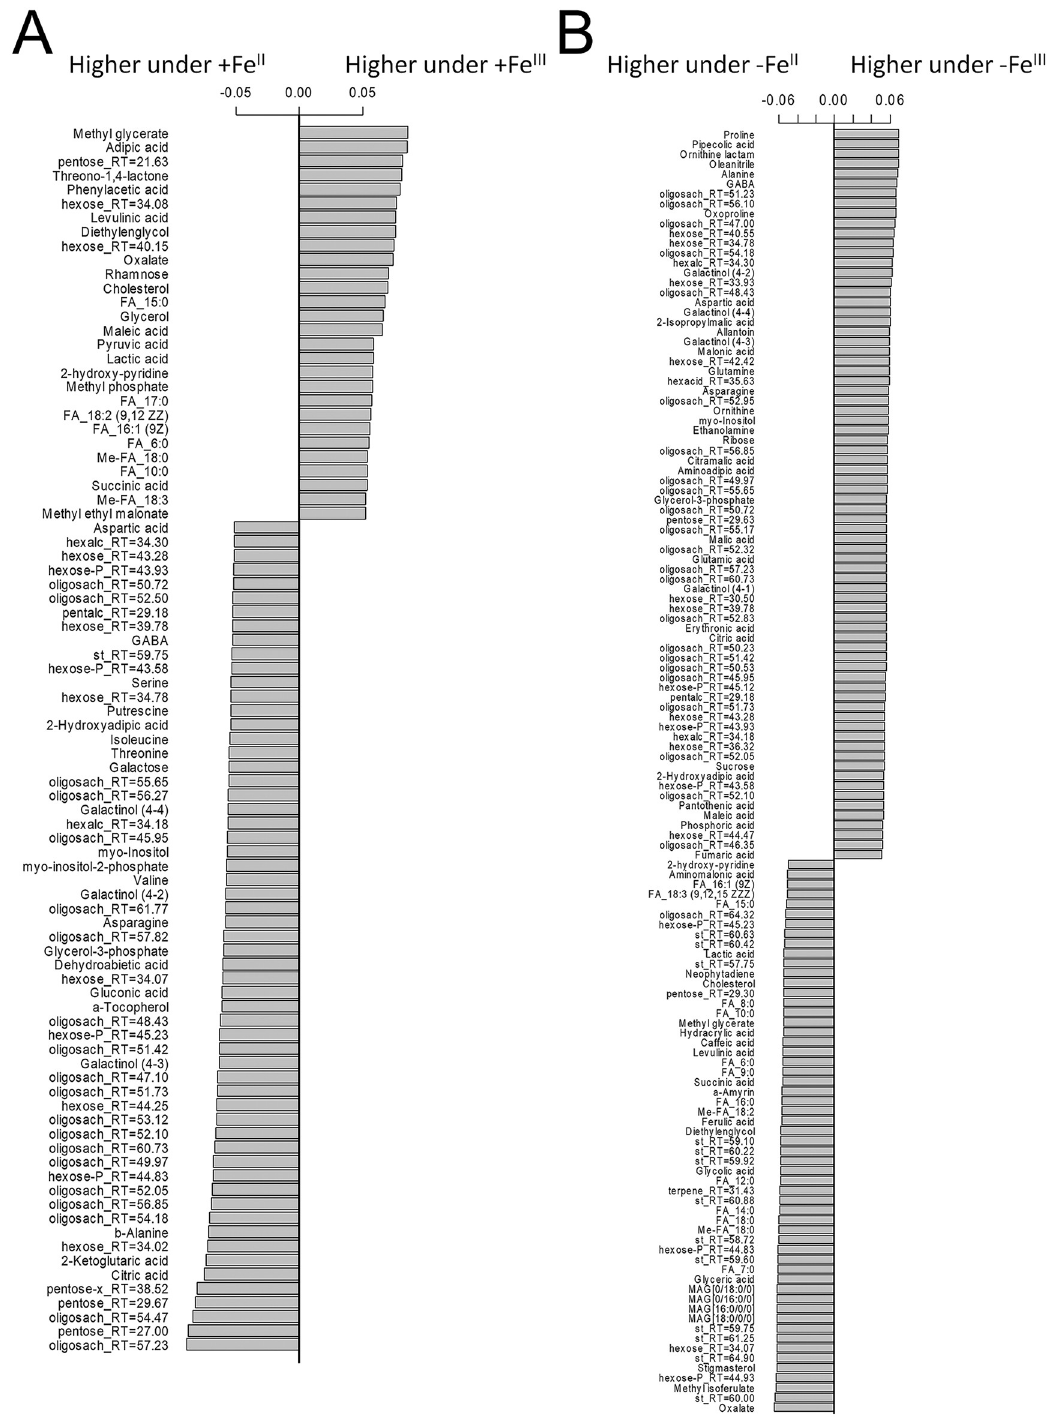
Fig 3. Selection of features discriminating cucumber plants grown hydroponically in a nutrient solution, either with (+Fe II and +Fe III ) or in Fe-free ( − Fe II and − Fe III ) nutrient solution, with or without the supply of 0 (F0), 1 (F1) and 2 (F2) mg L -1 fullerenol for 10 days. Barplots of loadings of predictive component (VIP > 1) derived from OPLS-DA comparing of the metabolome of cucumber grown in a nutrient solution with Fe II or Fe III : A—Fe-sufficient plants, B—Fe-deficient plants.